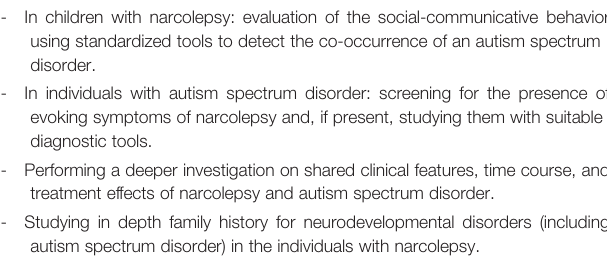
TABLE 2 | Possible connection between narcolepsy and autism spectrum disorder: the agenda of future research lines. - In children with narcolepsy: evaluation of the social-communicative behavior using standardized tools to detect the co-occurrence of an autism spectrum